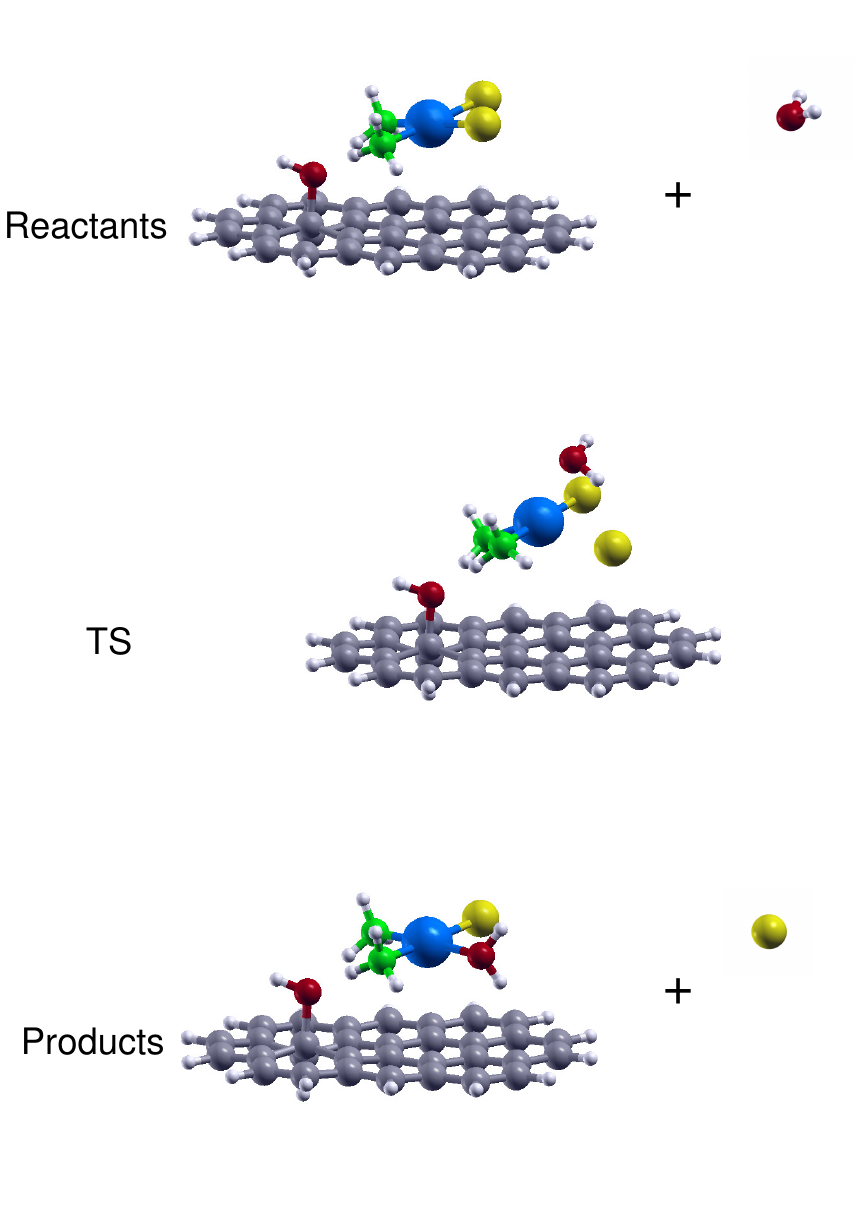
Figure 5. Side views of the reactants, transition state (TS) and products optimized structures related to the CP hydrolysis reaction with the drug adsorbed on a hydroxy site of a GO (or rGO) platelet. The reported structures are those obtained in aqueous solution by considering the SMD continuum solvation